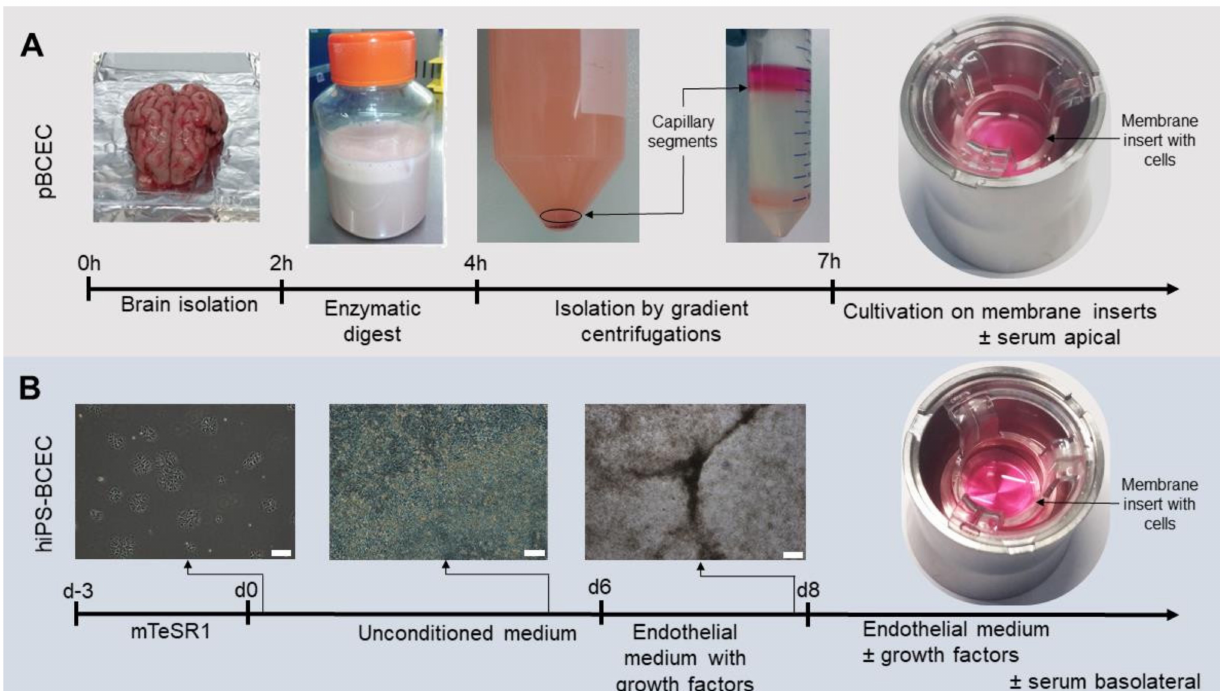
Figure 2. Generation of in vitro BBB models. ( A ) pBCECs were cultivated after isolation from a fresh brain of Sus scrofa domestica by consecutive enzymatic digestion and gradient centrifugation steps before seeding the isolated cells on membrane inserts to re-establish the BBB-specific